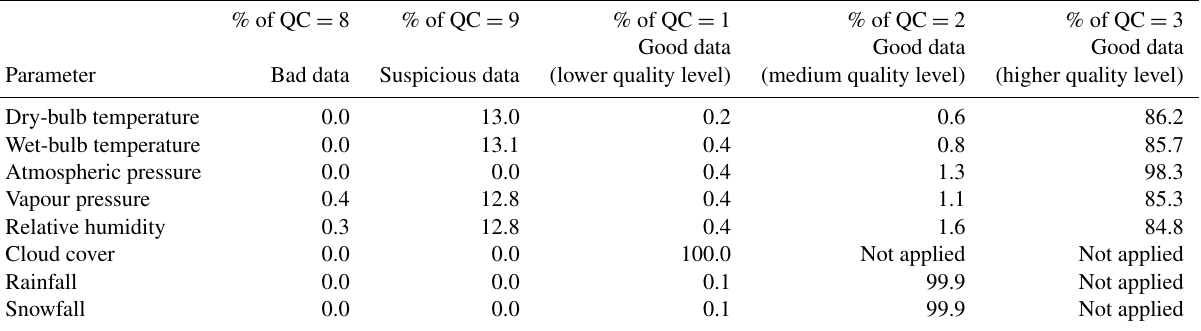
Table 3. Results of quality control tests applied to MVOBS sub-daily meteorological data. Each column shows the percentage of data flagged as QC = 8; QC = 9; QC = 1; QC = 2; and QC = 3. It should be noted that cloud cover data underwent only manual inspection and the gross error test, whereas rainfall and snowfall measurement quality was evaluated according to manual inspection as well as the gross error and tolerance